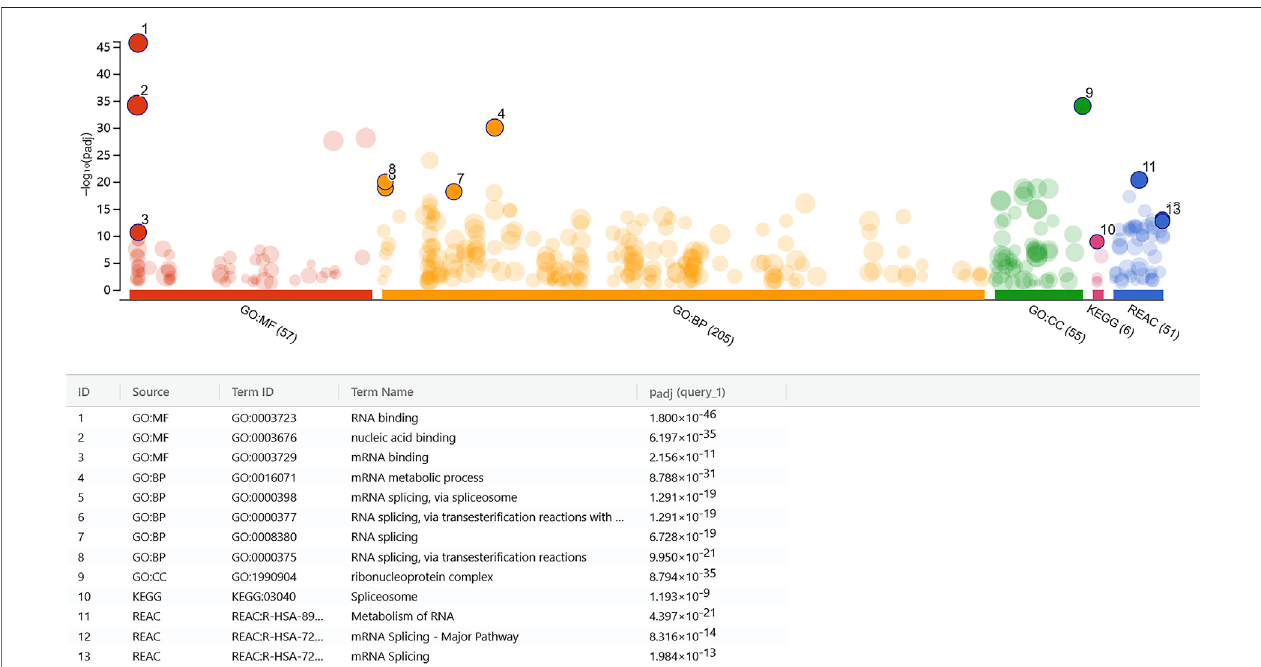
FIGURE 4 | rs7175517 might involve in the RNA splicing activities. Core protein was highly expressed in the DNA pull-down assay in three databases (GO, KEGG and REAC). The GO pathway enrichmentanalyses, including molecular function (MF), biological process (BP)and cellular component (CC), areindicated byred, orange and green.KEGG pathway enrichmentanalysisisindicatedbypink, and REAC pathway enrichmentanalysisisindicated byblue. Allresults indicated thatco-expressed proteins were enriched in RNA